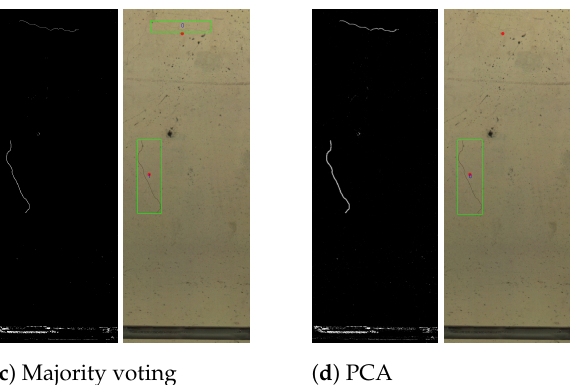
Figure 19. An example showing different detection results from majority voting and PCA. Reference